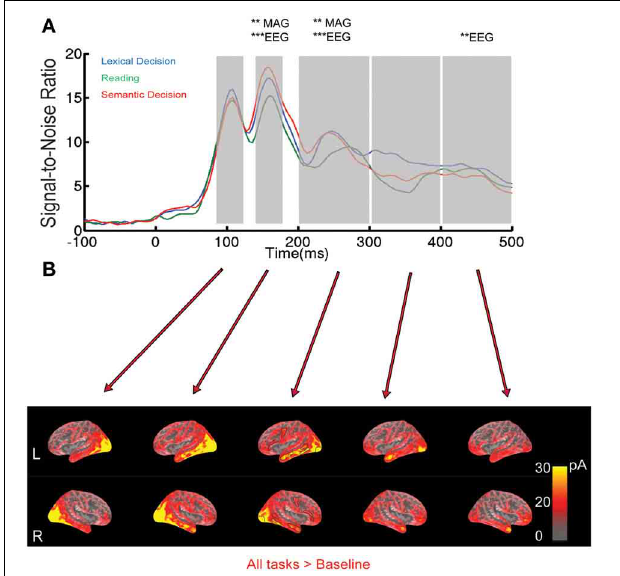
FIGURE 1 | EEG/MEG results for all words collapsed across the three tasks. (A) Root-Mean-Square (RMS) of Signal-to-Noise Ratio (SNR, based on standard deviation of baseline interval) across all EEG/MEG sensors over time. The shaded areas indicate the five time windows selected based on peaks in the RMS curves: 92–124, 144–176, 200–300, 300–400, and 400–492 ms. Asterisks indicate whether a One-Way ANOVA with factor Task was significant at a family-wise corrected level ( ∗∗ p < 0 . 01, ∗∗∗ p < 0 . 001). MAG stands for magnetometers. (B) EEG/MEG source estimates on a group-averaged inflated brain surface for words averaged across tasks in the time windows specified above. ROIs selected for further analysis are outlined in black in the middle